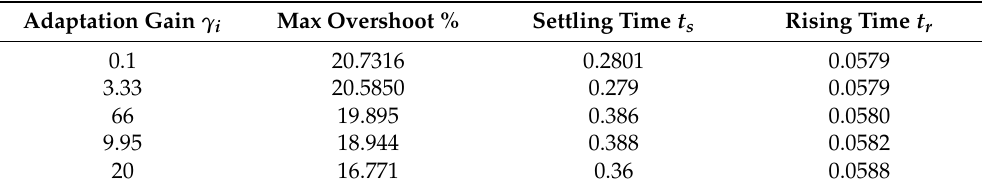
Table 3. Response variation as a function of γ i